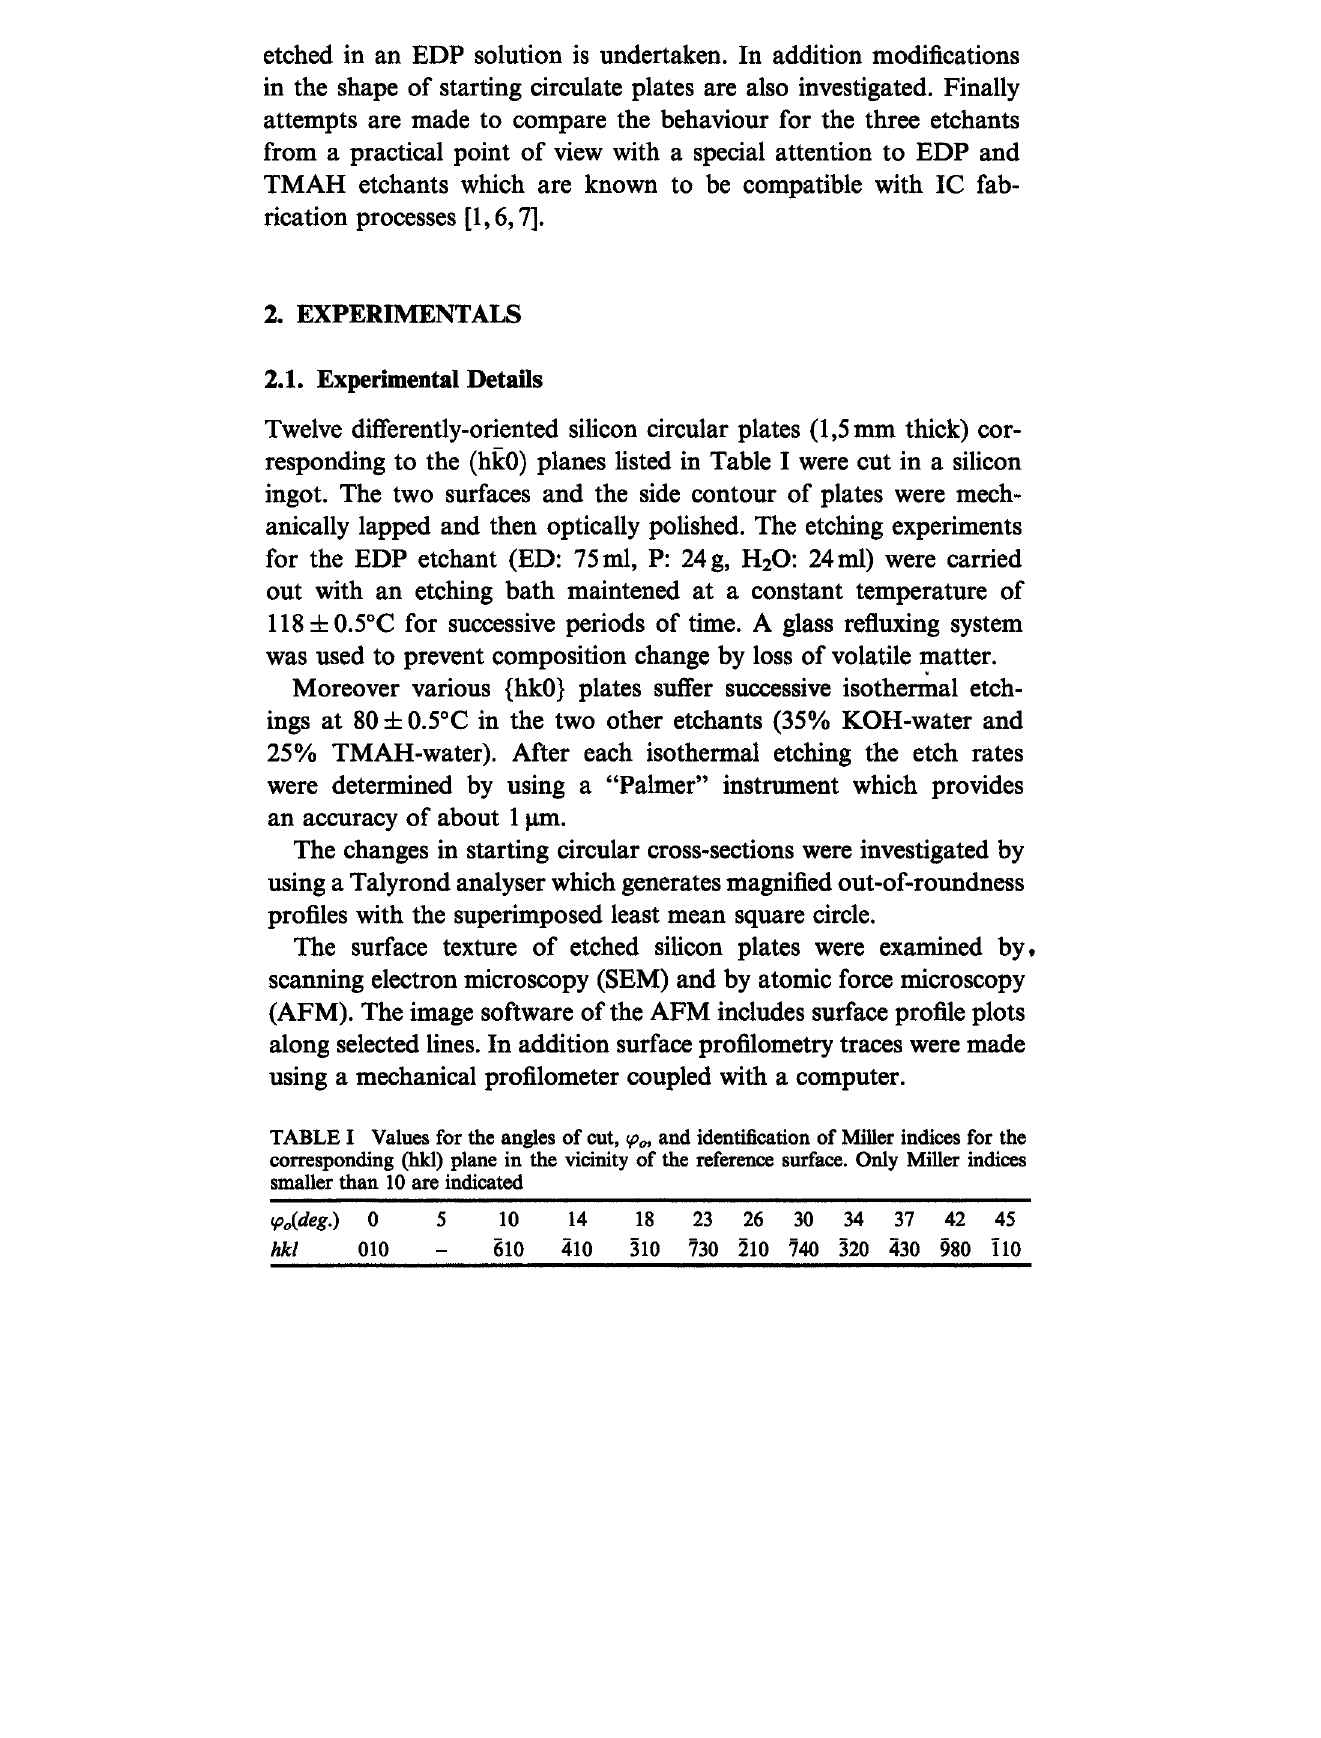
Values for the angles of cut, o, and identification of Miller indices for the corresponding (hkl) plane in the vicinity of the reference surface. Only Miller indices smaller than 10 are indicated